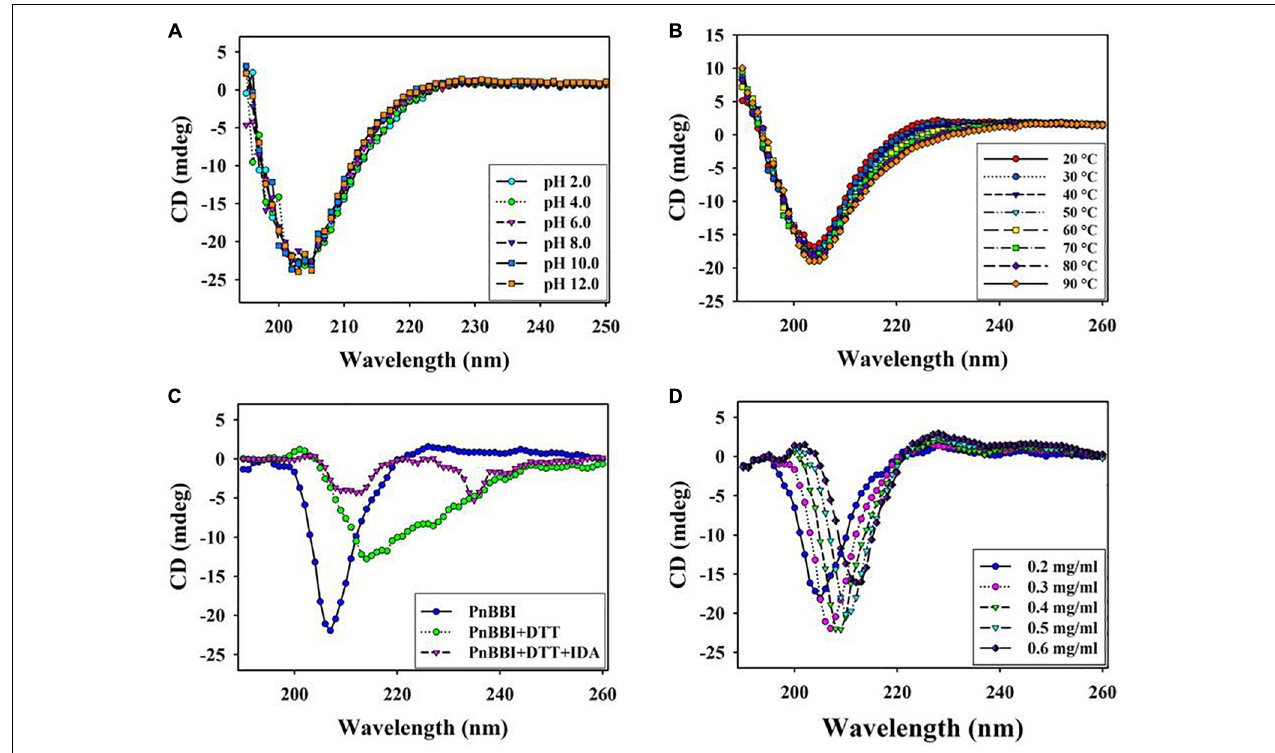
FIGURE 6 | Structural stability of PnBBI. Far-UV (190-260 nm) secondary structure of PnBBI was determined by CD spectroscopy at different (A) pH from 2.0 to 12.0; (B) temperatures from 20 to 90 ◦ C; (C) DTT (2 mM) reduction followed by IDA (4 mM) alkylation and (D) increasing concentration (0.2 - 0.6 mg/ml) of PnBBI prepared in 10 mM PBS, pH 7.4 as described in methods. The final spectrum is an average of three scans as described in Section “Circular Dichroism